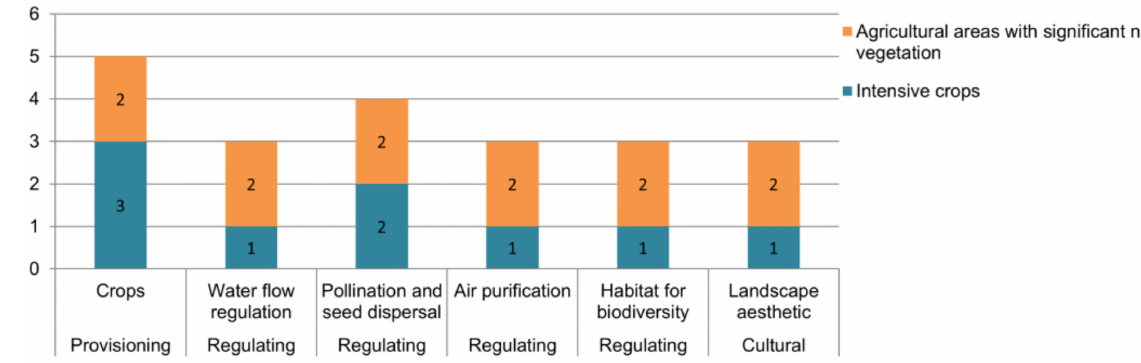
Figure 3. List of the six most ranked ES through mapping and